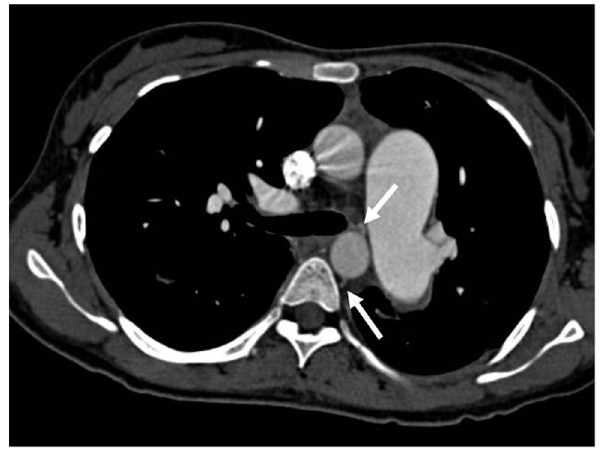
Figure 3. The pulmonary artery diameter was measured at the trunk of the pulmonary artery, on axial CT angiography slices using electronic callipers.